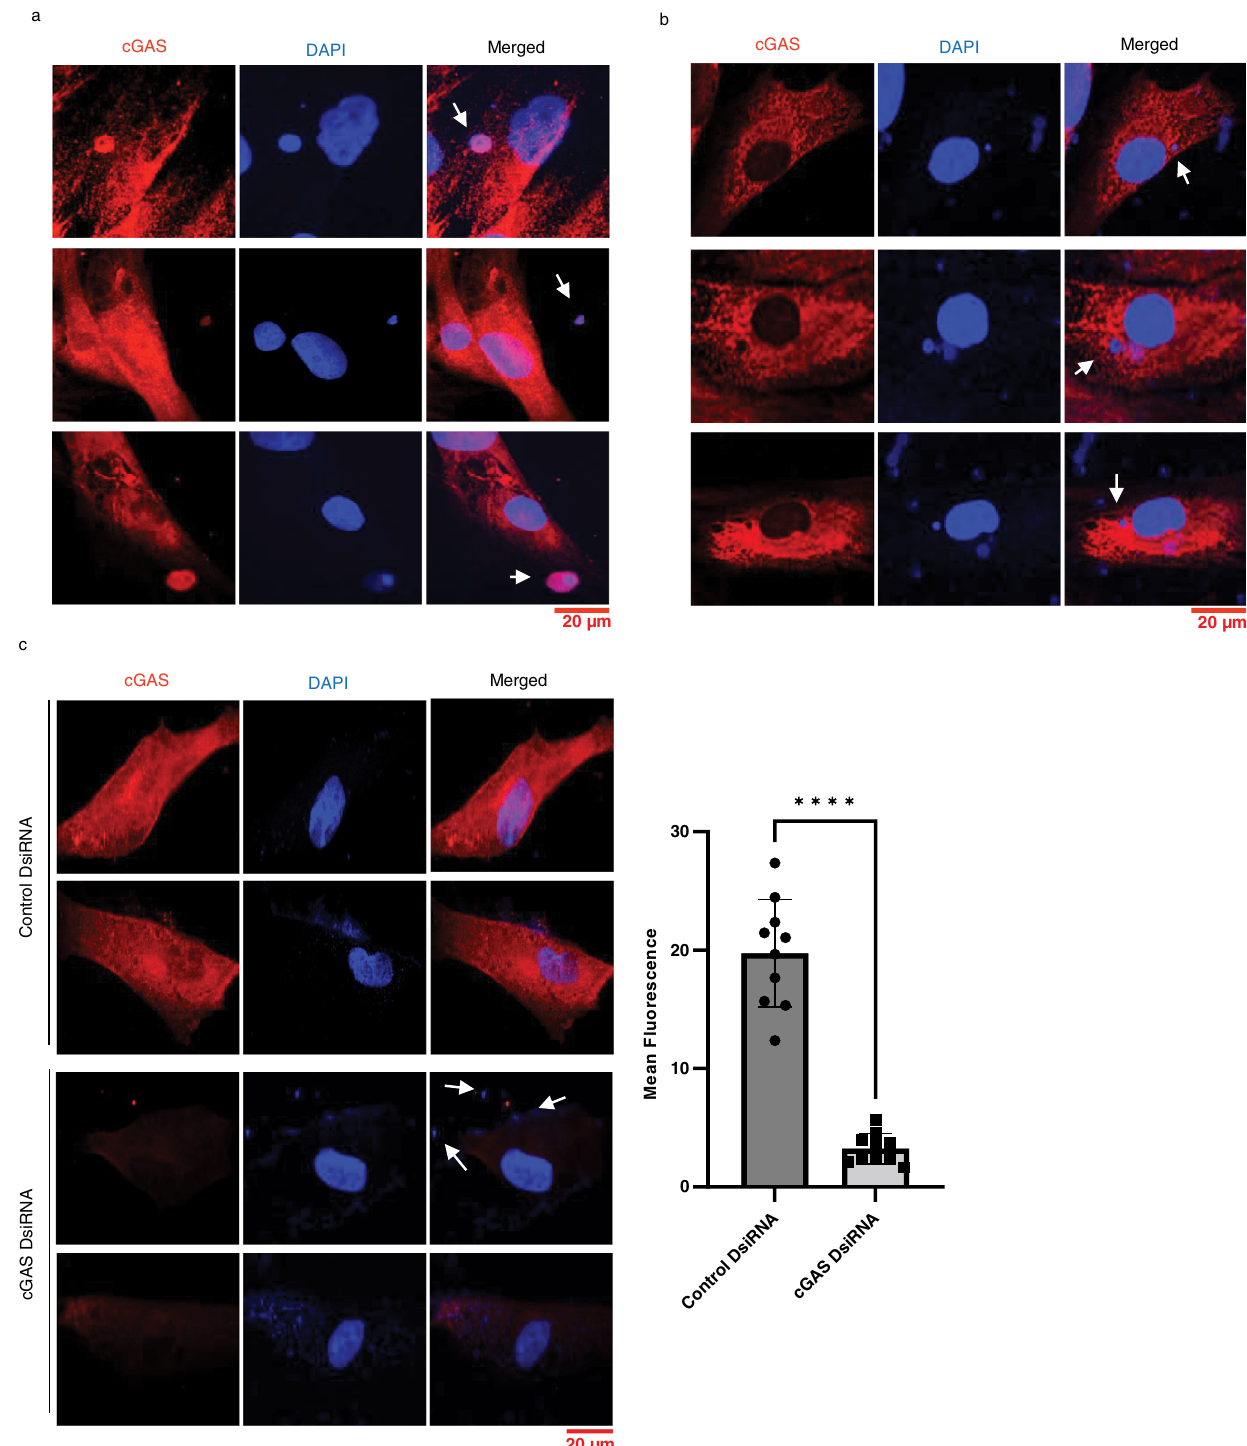
Fig. 6 | Colocalization of cGAS to micronuclei in SSc fi broblasts. IF analysis of expression ofcGAS(red)in SSc fi broblasts. Nuclei and micronucleiwerestained in DAPI (blue). a Micrographs showing cGAS expression and colocalization to micronucleiin anlcSScpatient(111). b Micrographsshowing onlycGAS expression but not co-localization to micronuclei in the same lcSSc patient (111). c Con fi rmation of the speci fi city of c-GAS staining in a and b . Representative fl uorescence images and quanti fi cation using ImageJ showing reduction of cGAS